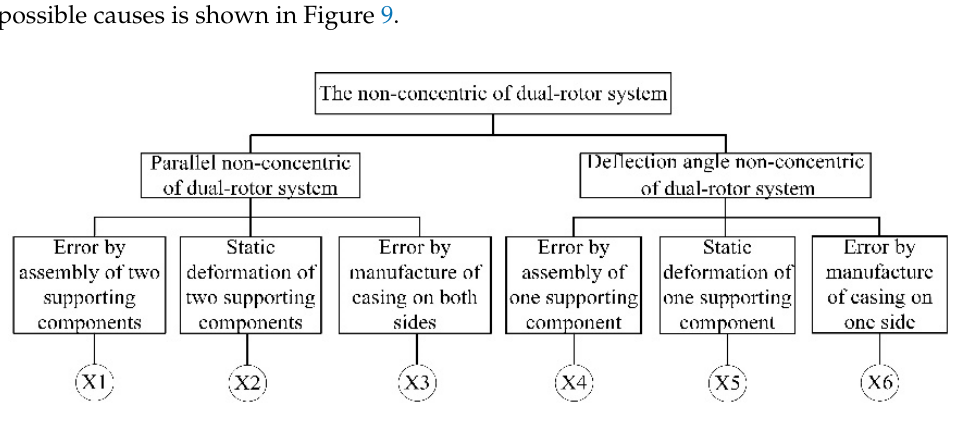
Figure 9. Non-concentricity fault tree of dual-rotor systems.